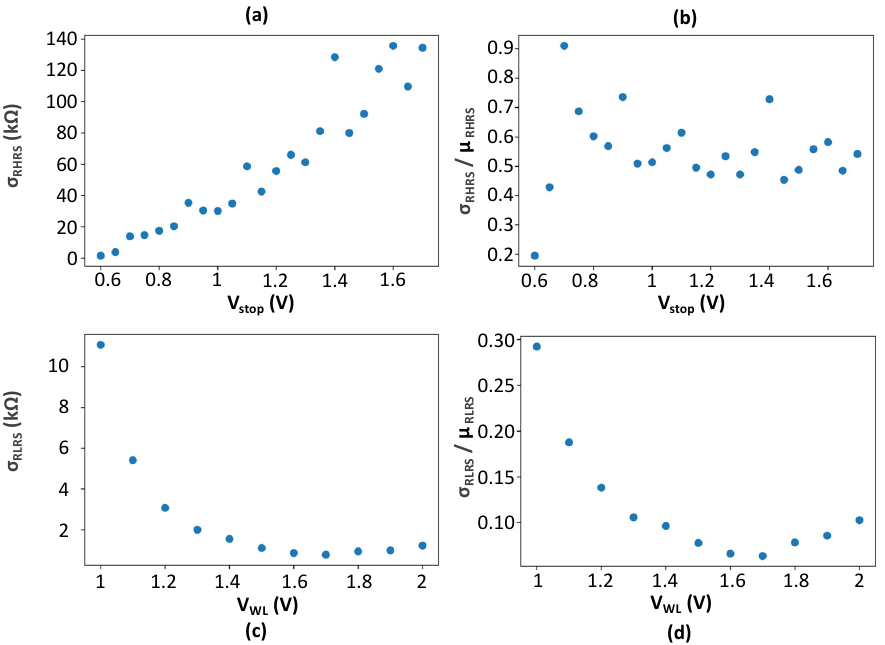
Figure 13. ( a ) HRS standard deviation versus V stop voltage steps and ( b ) σ / µ ratio variation versus V stop . ( c ) LRS Standard deviation versus V WL voltage steps and ( d ) σ / µ ratio variation versus V WL .